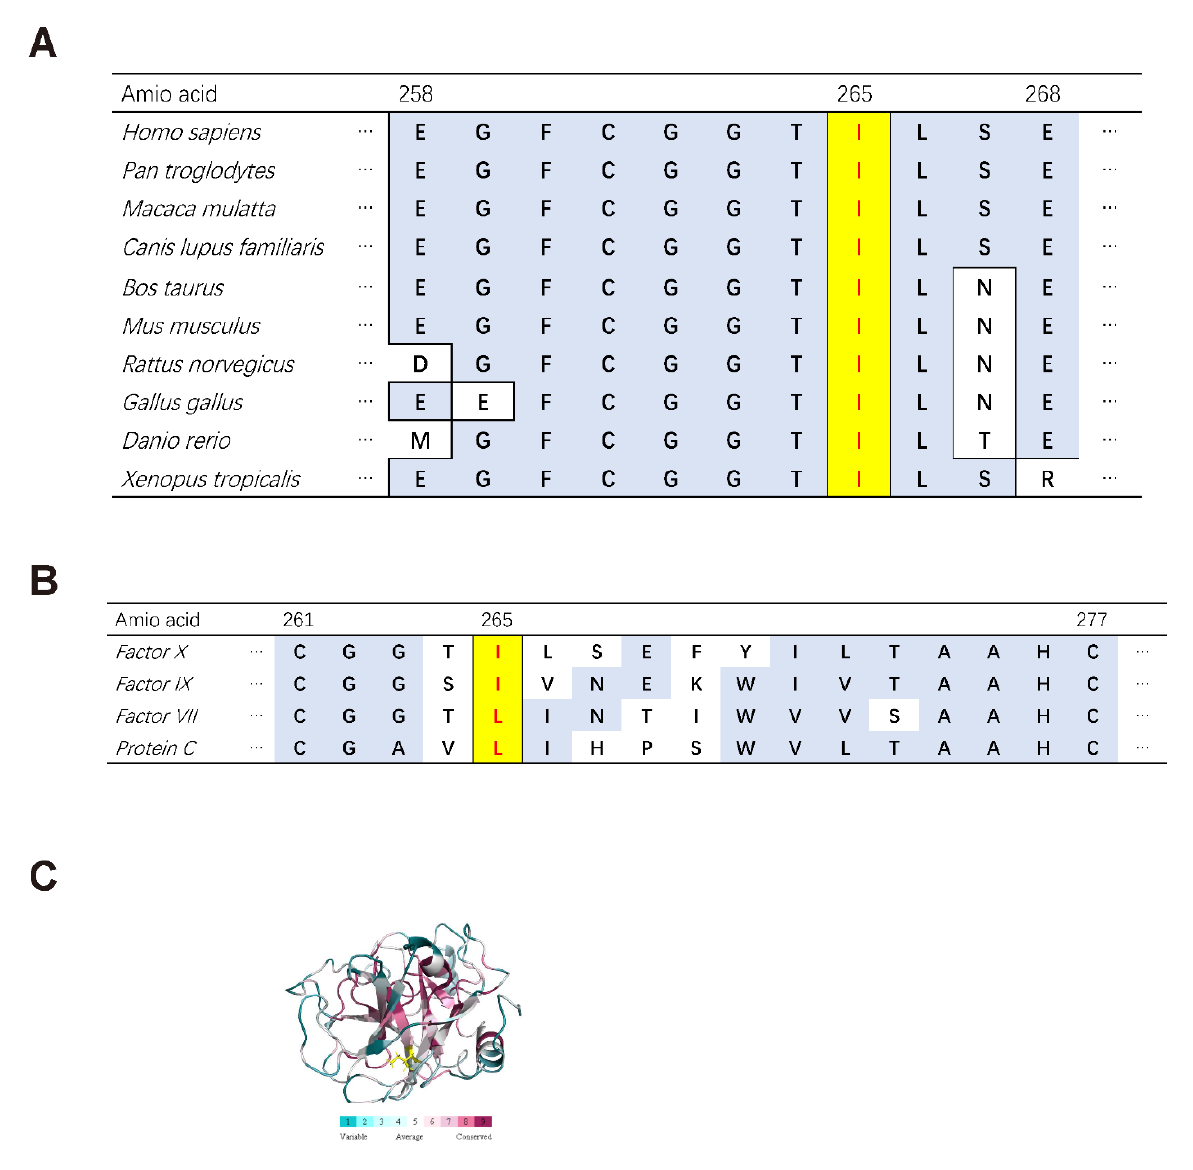
Figure 8. ( A ). Comparison of amino acid alignments around Ile265 among different species. ( B ). Comparison of amino acid alignments around Ile265 among FVII (Factor VII), FIX (Factor IX), PC (Protein C). ( C ) . The position of Ile265 (the yellow sticks) in FX and conservation picture of the FX protein (heavy chain) using Pymol.